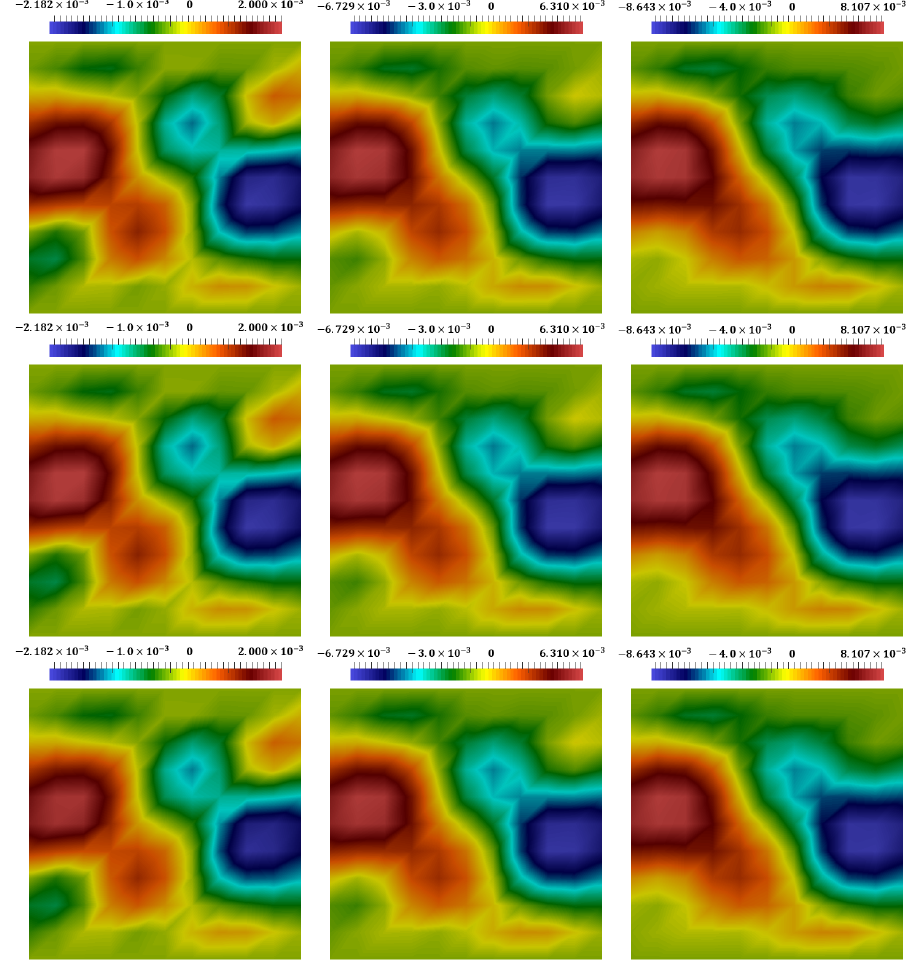
Figure 8. Distribution of displacement in x 2 direction at different times, t m with m = 0.4,0.8,1 (from left to right ). ( The first row ): the coupled explicit–implicit solution. ( The second row ): the split explicit–implicit solution. ( The third row ): the proposed approach’s solution.